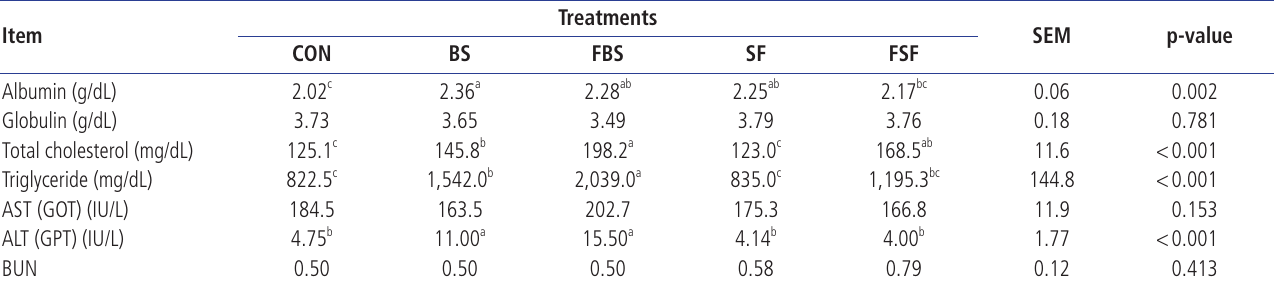
Table 6. Effects of dietary supplementation with non-fermented or fermented by-products of brown seaweed and seaweed fusiforme on blood profiles in laying hens Item